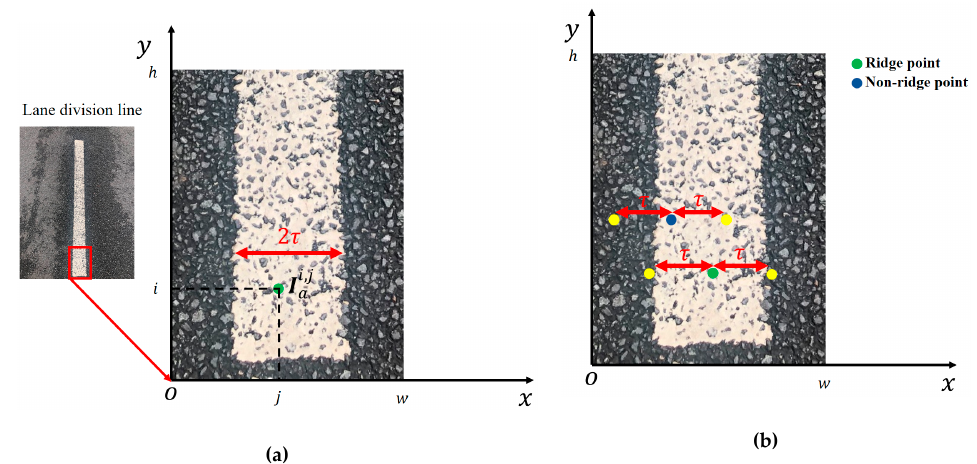
Figure 4. Ridge detector illustration. ( a ) ridge point illustration. ( b ) Equation (2) illustration